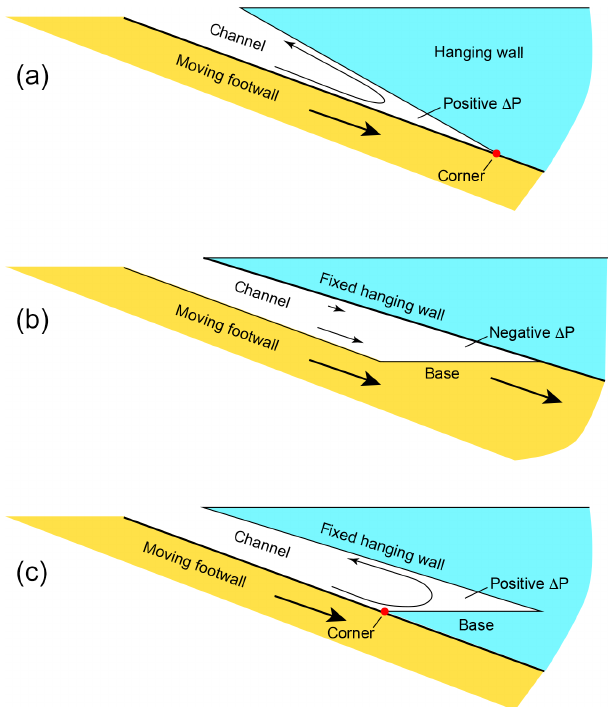
Figure 1. (a) Downward tapering subduction channel illustrating a configuration that can lead to corner flow and positive dynamic overpressure ( (cid:49)P ). (b) Geometrical and kinematic configuration of the Himalayan subduction zone as described by Marques et al. (2018). The base of the channel moves with the lower plate, and (cid:49)P is negative. (c) Configuration used for calculations in the model by Marques et al. (2018). The base is attached to the upper